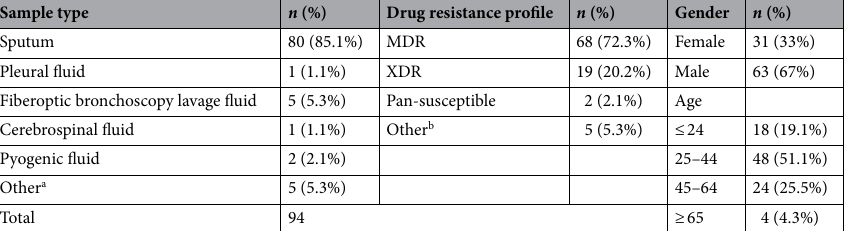
Table 1. Characteristics of clinical samples used in this study. Other a : samples did not belong to the above five types; Other b : isolates were resistant to one or several MDR- or XDR-relevant drugs, but were not defined as the types above.